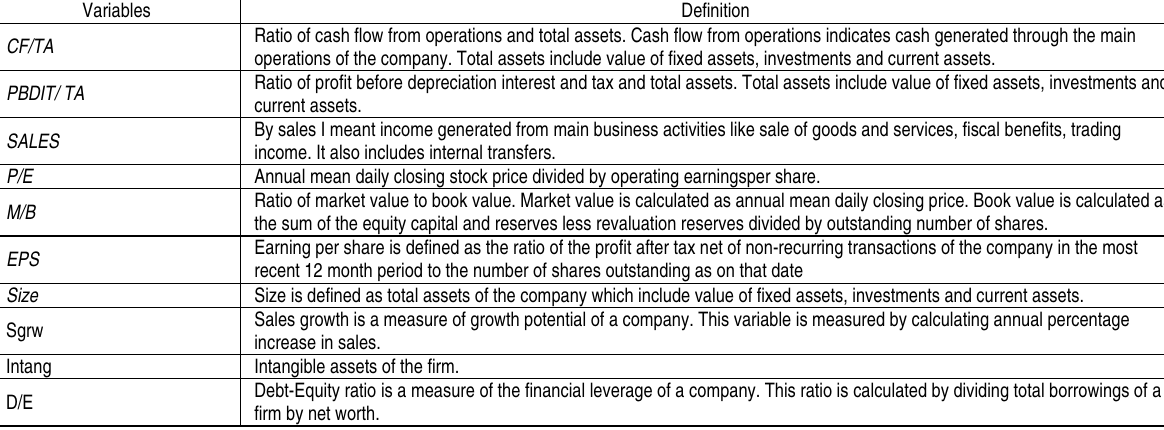
Fig. 1. Time series of de-trended monthly moving average IPO volume Table 2. Definitions of firm-specific variables used in this